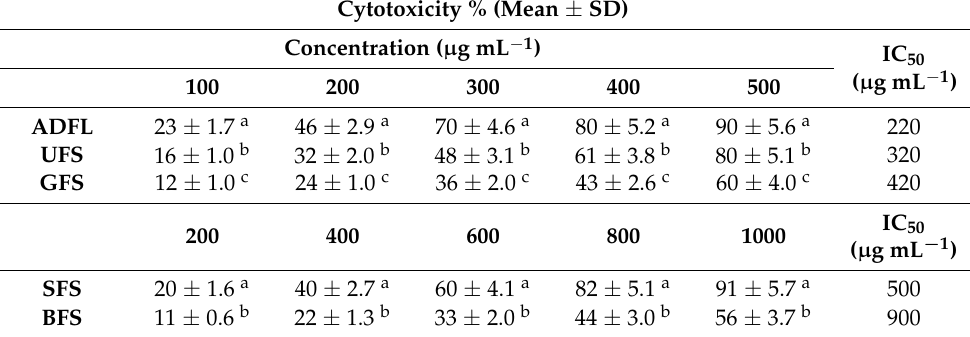
Table 1. Anti-proliferative activity and IC 50 ( µ g mL − 1 ) values of ethanolic crude extracts of air- dried fenugreek leaves (ADFL), untreated fenugreek seeds (UFS), germinated fenugreek seeds (GFS), soaked fenugreek seeds (SFS), and boiled fenugreek seeds (BFS) against human hepatic carcinoma cell line